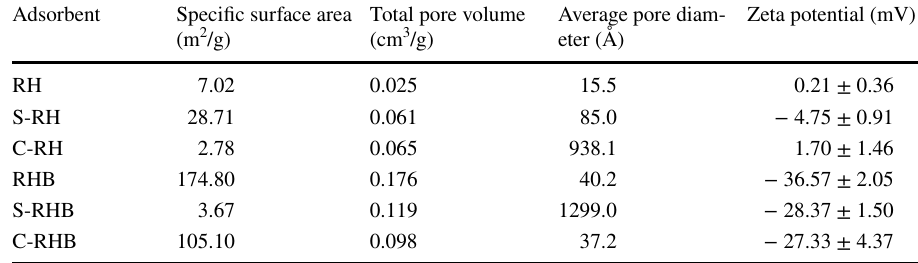
Table 1 Specific surface area, total pore volume, average pore diameter, and zeta potential of each